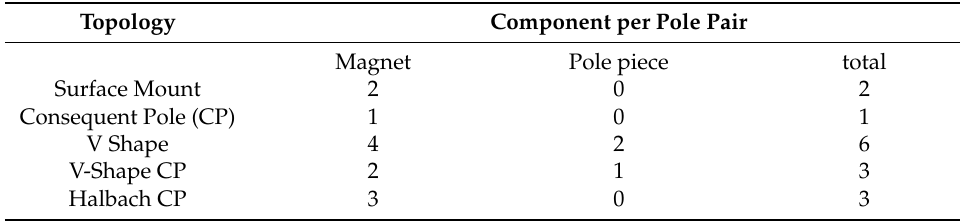
Table 1. Component count of stator variants of the VHM. Topology Component per Pole Pair Magnet Pole piece total Surface Mount 2 0 2 Consequent Pole